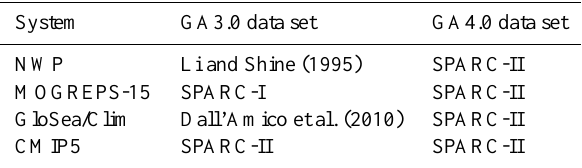
Table 5. Source data used to create ozone ancillaries in the fol- lowing GA3.0/3.1 and GA4.0 systems: NWP: 1–6-day NWP fore- casts; MOGREPS-15: the 15-day global component of the Met Of- fice Global and Regional Ensemble Prediction System; GloSea: the Met Office Global Seasonal forecast system; Clim: standard data set used in GA3.0 climate runs; and CMIP5: GA3.0 climate runs set up to use CMIP5 forcing data (Taylor et al.,